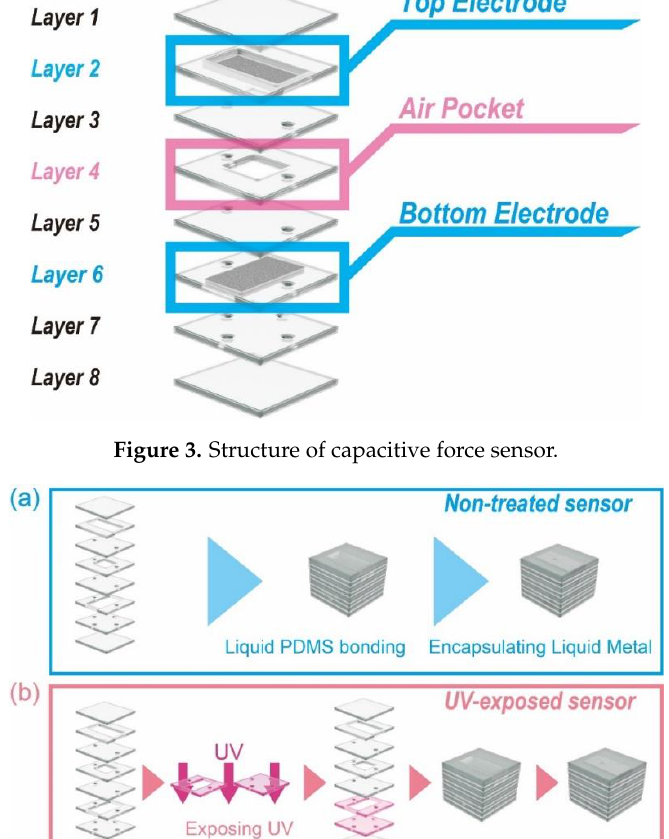
Figure 5. Photograph of the fabricated sensor.